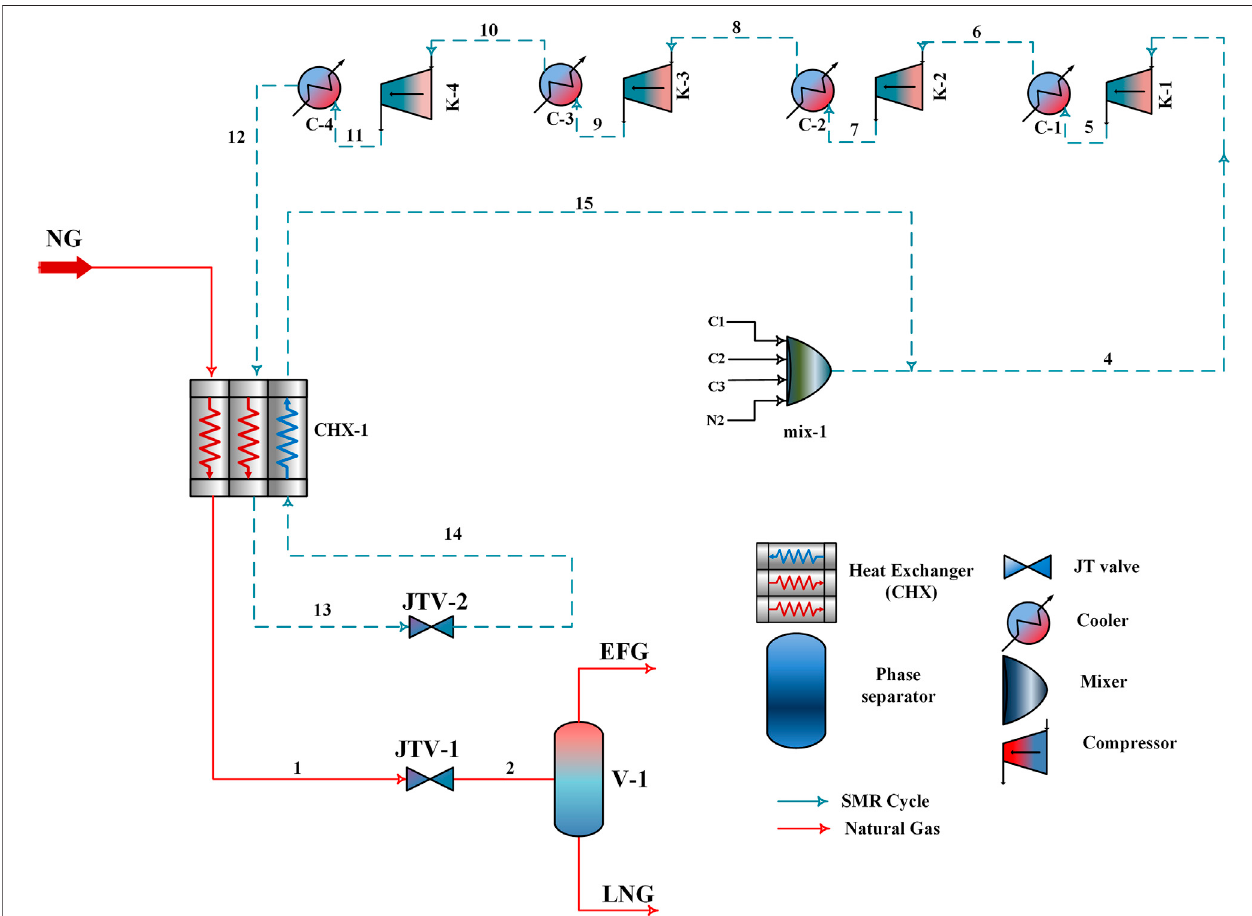
FIGURE 3 | Schematic representation of the process fl ow diagram of the SMR-LNG process.